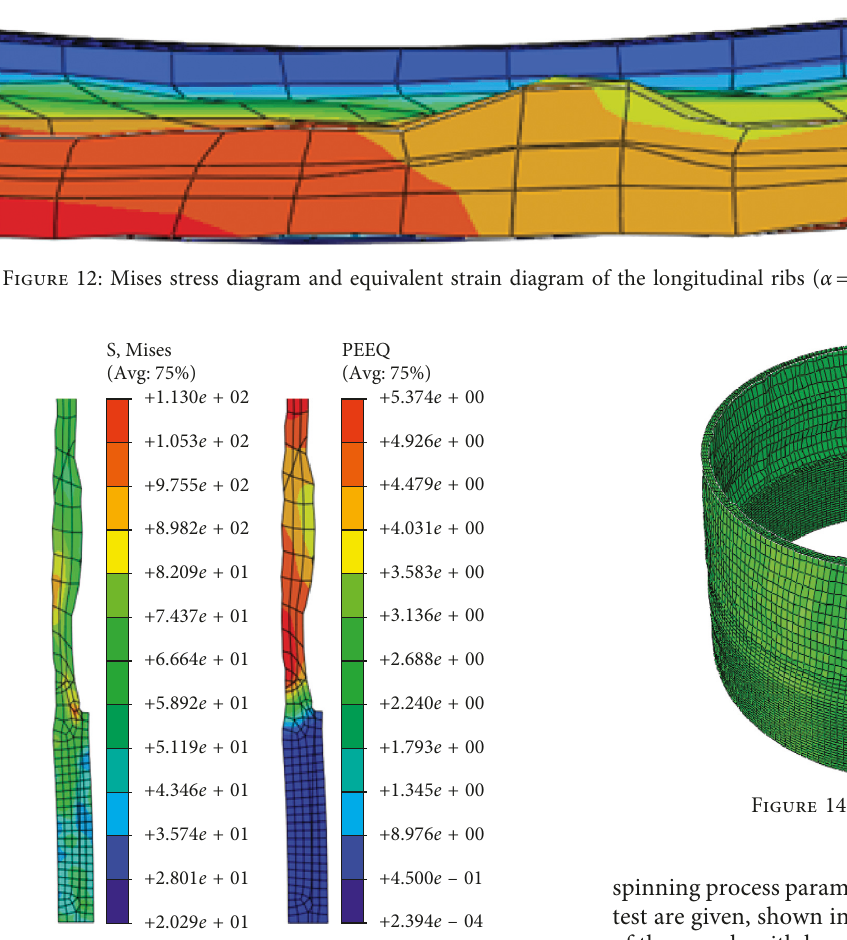
Figure 13: Mises stress diagram and equivalent strain diagram of the latitudinal ribs ( α � 22 ° , Ψ � 50%, and f � 180 mm/min).